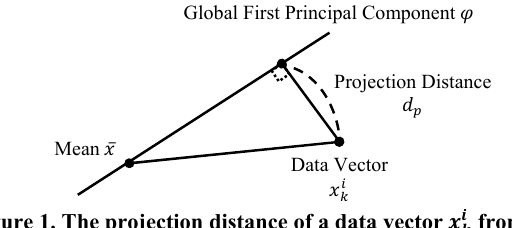
Figure 2. Updating the global normal pattern.